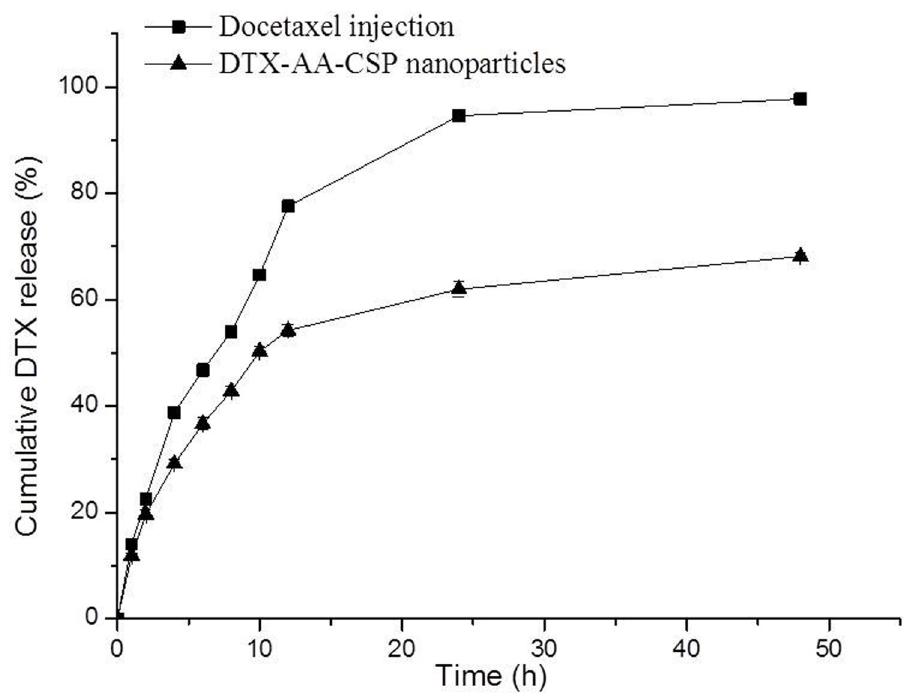
FIGURE 7 - In vitro release profiles of DTX from docetaxel injection (- -) and DTX-AA-CSP nanoparticles (- -) in pH 6.8 phosphate-buffered saline containing 0.5% of Tween 80 at 37 ± 0.5 °